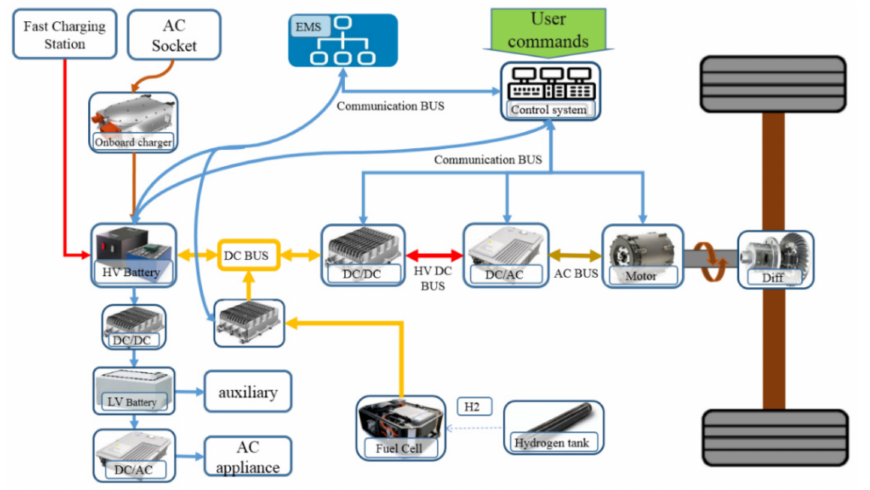
Figure 3. Power electronics of an